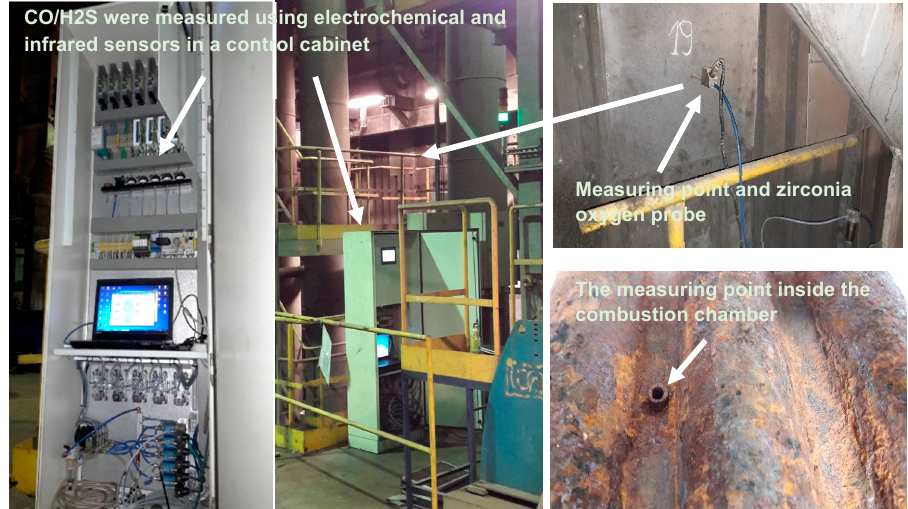
Figure 2. View of the measuring system (measuring point and control cabinet) covering the front wall of the OP-230 boiler.